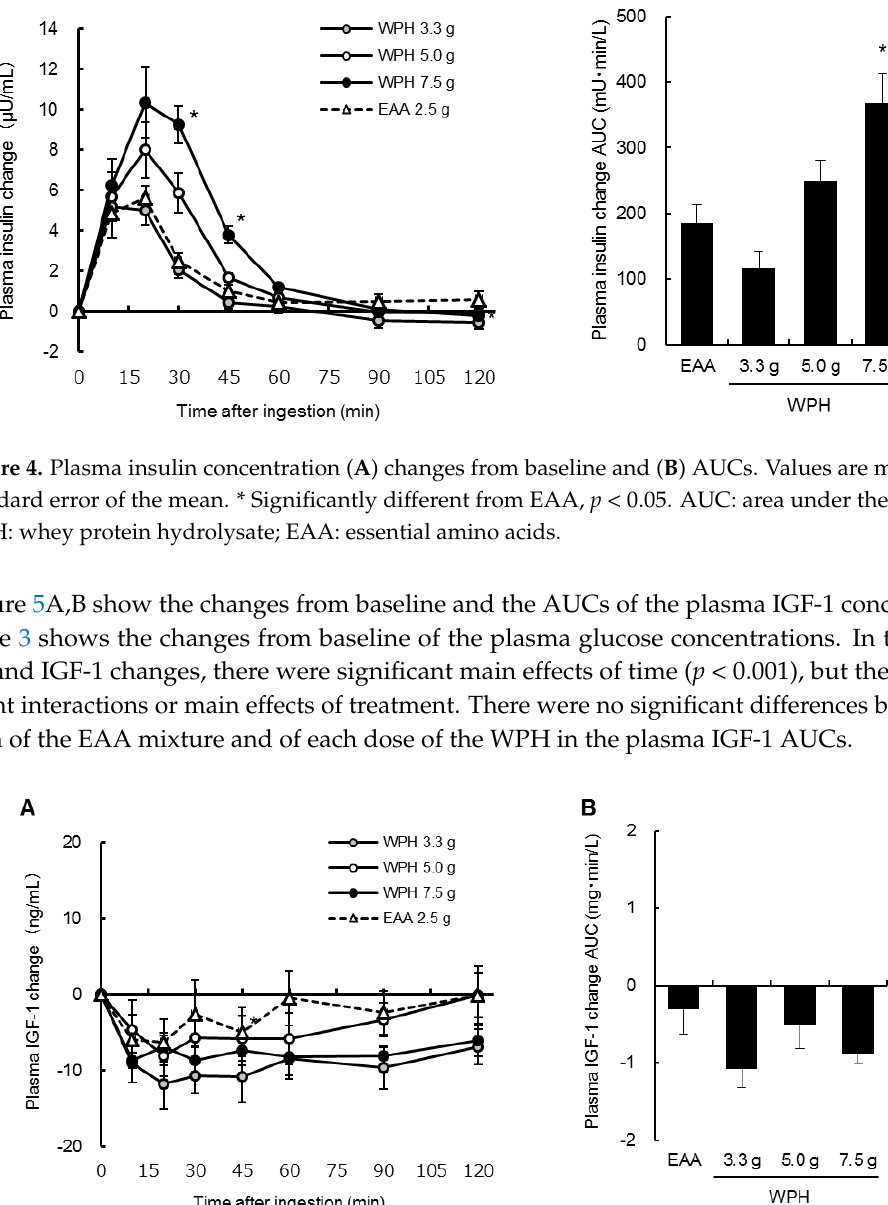
Figure 5. Plasma IGF-1 concentration ( A ) changes from baseline and ( B ) AUCs. Values are mean ± standard error of the mean. AUC: area under the curve; WPH: whey protein hydrolysate; EAA: essential amino acids.